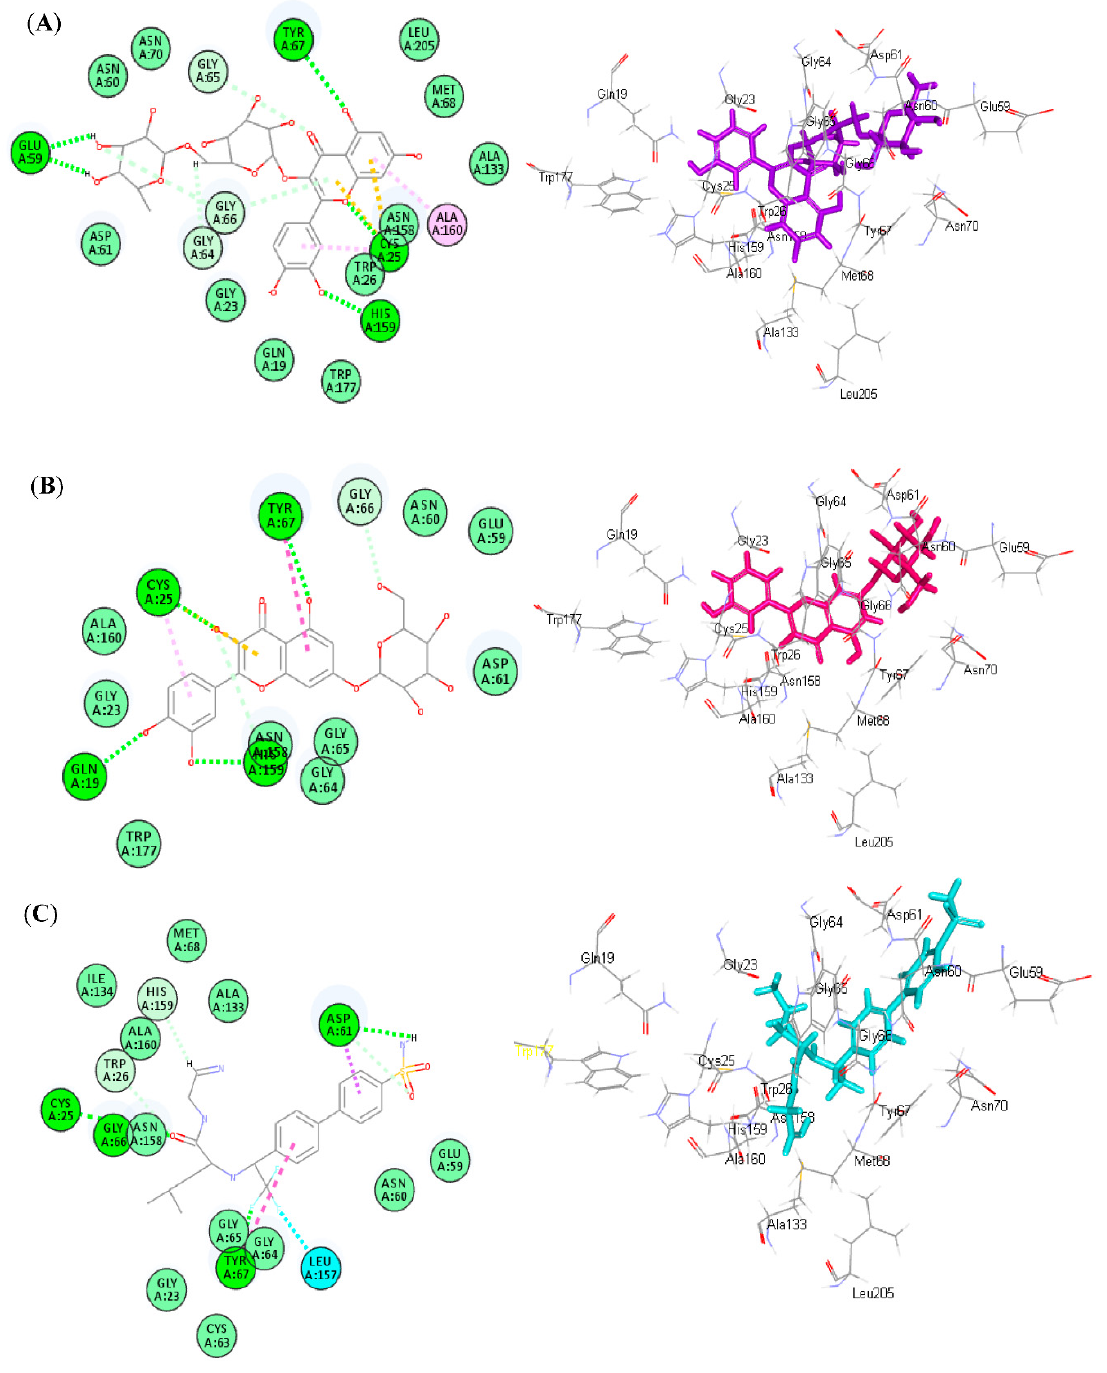
Figure 5. The 2D and 3D binding modes of rutin (4) ( A ), luteolin-7- O - β -glucoside (6) ( B ), and Co-crystalized ligand (NFT) ( C ) inside the active center of the active sites of cathepsin K; heavy green dotted bond, H-bonds; heavy pink dotted bond, π - π bonds; light green dotted bond, C-H bonds; light pink dotted bond, π -alkyl bonds; purple dotted bond, π - δ bond; orange dotted bonds, π -sulphur bond; blue dotted bond, halogen bond.